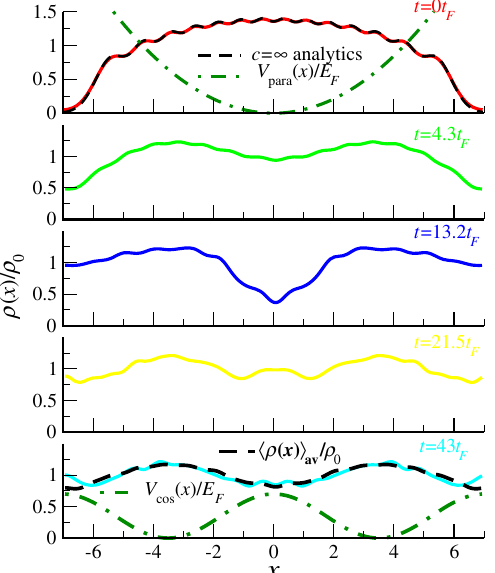
FIG. 2. The density profile of the gas at selected times post- quench as computed with the NRG. Here, this time dependence is computed after releasing an N ¼ L ¼ 14 , c ¼ 7200 gas prepared in a parabolic potential with m ω 2 0 L 2 = 2 E F ¼ 10 . 36 [shown with a green dashed line in the t ¼ 0 t F frame, t F ¼ 1 =E F , k 2 = ð 2 m Þ , and k π ð N − 1 Þ =L ] into a cosine potential E F ¼ F ¼ F x Þ =E 0 . 35 ð cos ½ð 4 π =L Þ x (cid:3) þ 1 Þ (plotted with a dashed V F ¼ cos ð line in the t ¼ 43 t F frame). In the t ¼ 0 frame, we show the density profile as computed analytically in the hard-core limit (see Appendix A 2). Using the NRG, we can run the time evolution as far out as t ¼ 85 t F before dephasing exceeds 1%. We see, however, by t ¼ 43 t F the gas ’ s density profile has already come close to its long time average (black dashed line in the final